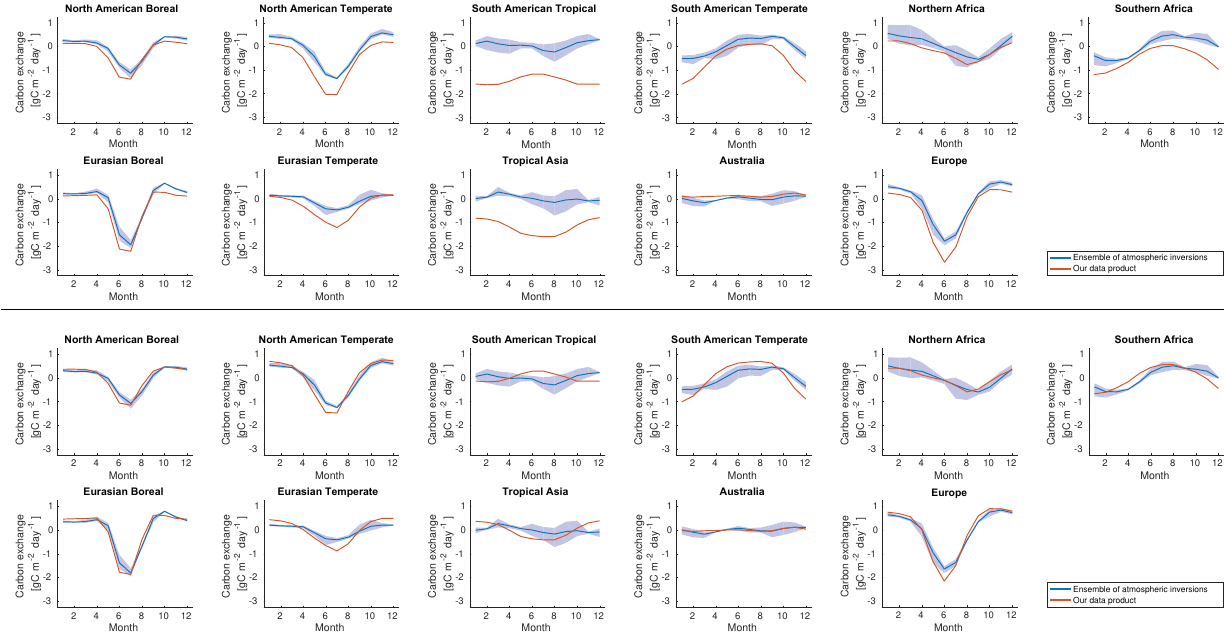
Figure 15. Comparison of our upscaled global NEE fluxes (red lines) with an ensemble of atmospheric CO 2 inversions (blue lines) con- sidering the mean seasonal cycle (MSC) for 11 TransCom regions estimated from the years 2001 to 2010. For the ensemble of atmospheric inversions, the average MSC among the ensemble members is shown together with shaded regions spanned by minimum and maximum values within the ensemble.